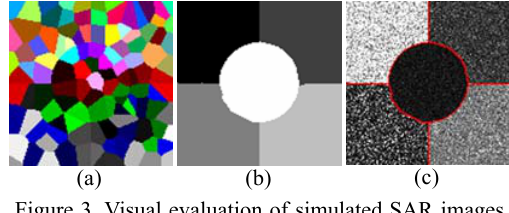
Figure 3. Visual evaluation of simulated SAR images, (a) Voronoi tessellation and (b) segmentation results (c) overlaying the extracted outlines on the original images.